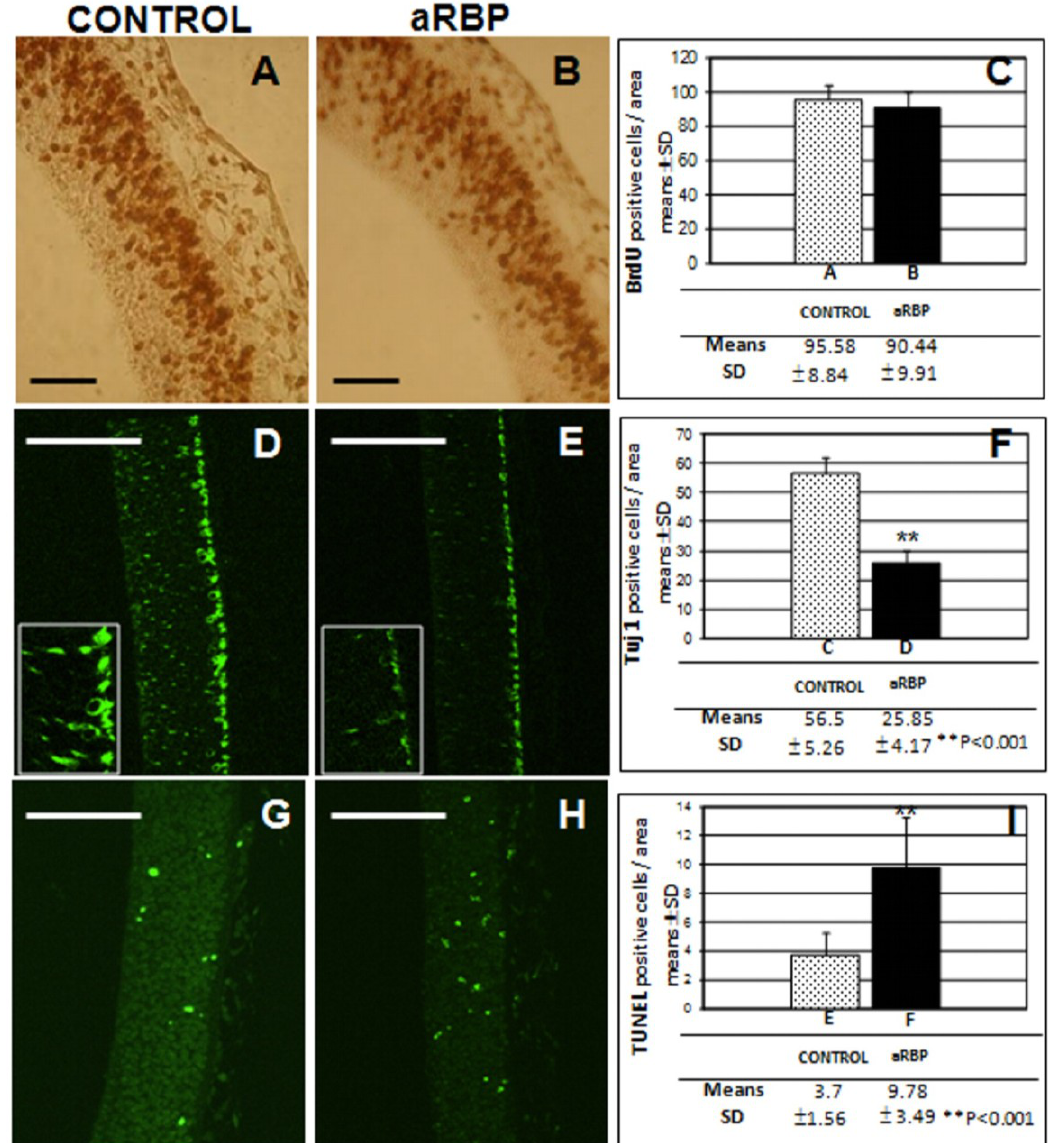
Figure 3. Evaluation of basic cellular behavior of mesencephalic precursor cells in control chick embryos ( A , D , G ) or after Retinol Binding Protein immunoblocking in CSF ( B , E , H ). ( A ) and ( B) show BrdU labeled nucleus used to evaluate cellular replication, of which values were plotted in ( C ), with no significant differences between both groups. ( D ) and ( E ) show cytoplasm expression of β3-Tubulin (Tuj1) used to evaluate early neurogenesis, of which values were plotted in ( F ), and show a significant decrease in neurogenesis after RBP immunoblocking. ( G ) and ( H) show cellular apoptosis measured by the TUNEL technique and the results were plotted in ( I ) and a small but significant increase of RBP inmunoblocking (scale bar in ( A ) and ( B ): 50  m; scale bar in ( D - E ) and ( G - H ): 100 